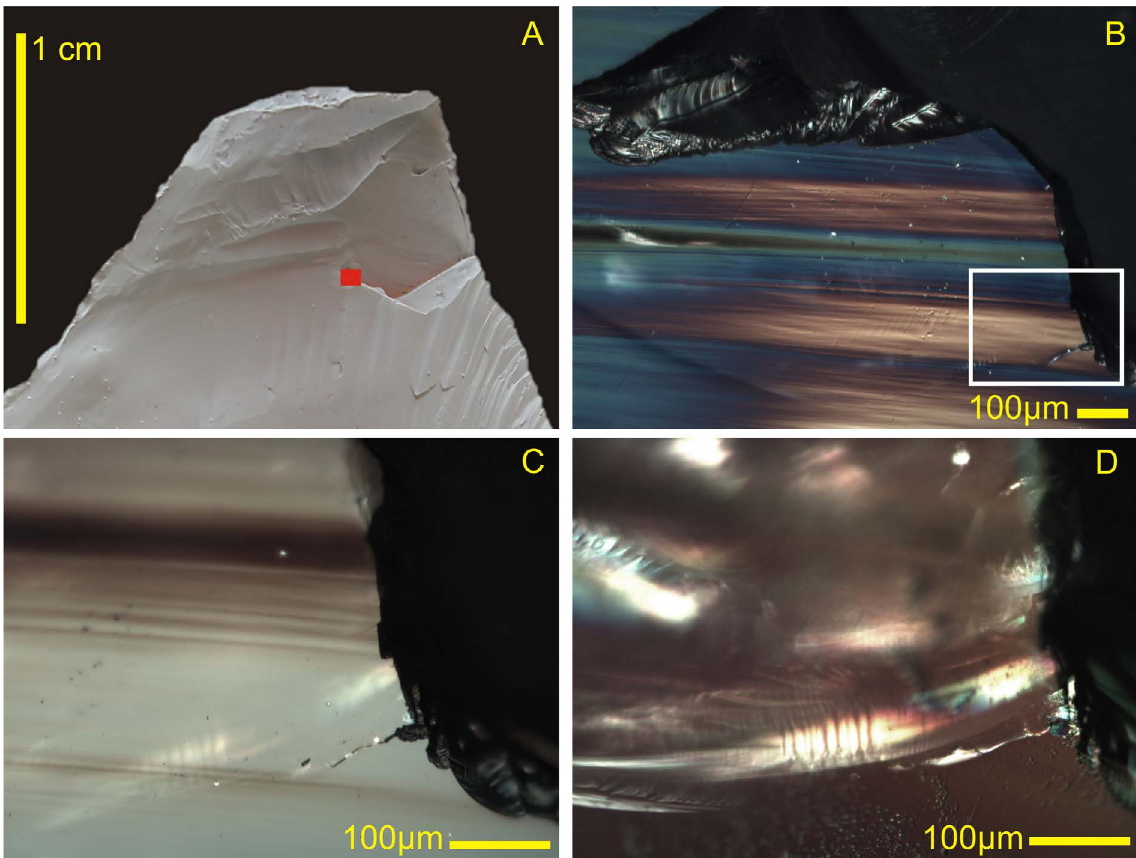
Figure 9. Impact macro-fracture in the distal area of the ventral face; A. Macro-fracture with magnesium. The red rectangle represents the area of the image B; B. Detail of the macro-fracture at 100x, the white rectangle represents the images C & D; C & D. The same point at 200x but with changes in the orientation of the light with the Nomarski prism. In image D it is more evident that the surface is not detached although is fractured.